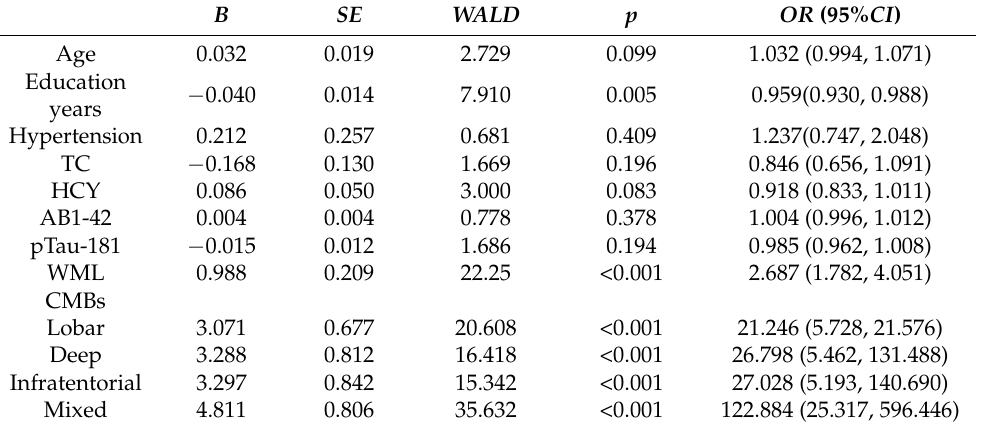
Table 7. Multivariate analysis results of the risk factors for cognitive impairment.